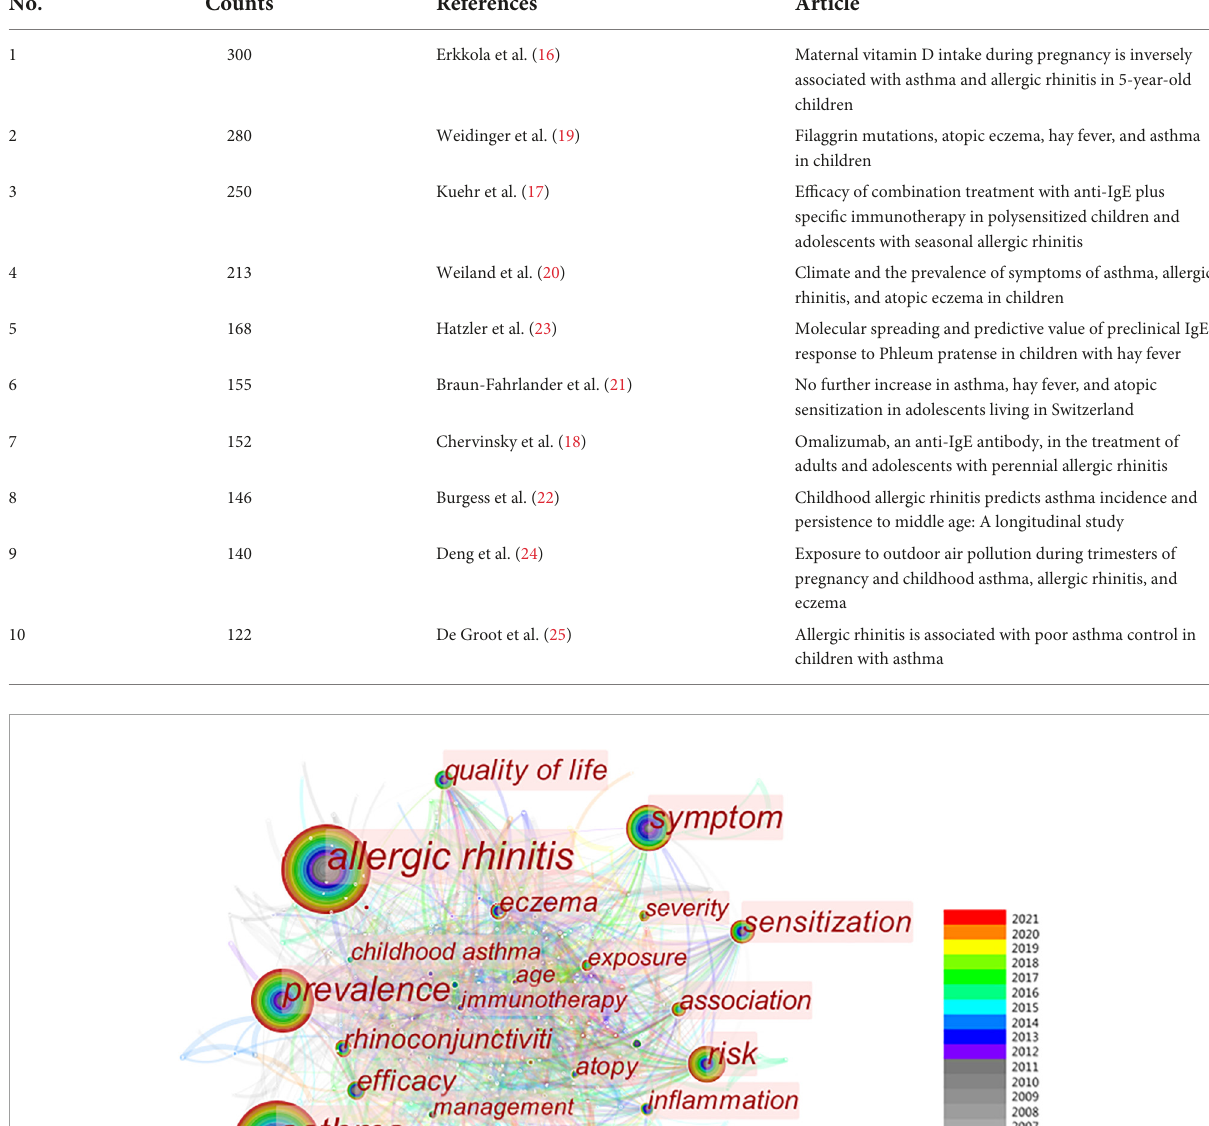
TABLE 5 The top 10 references with the most co-citation counts.